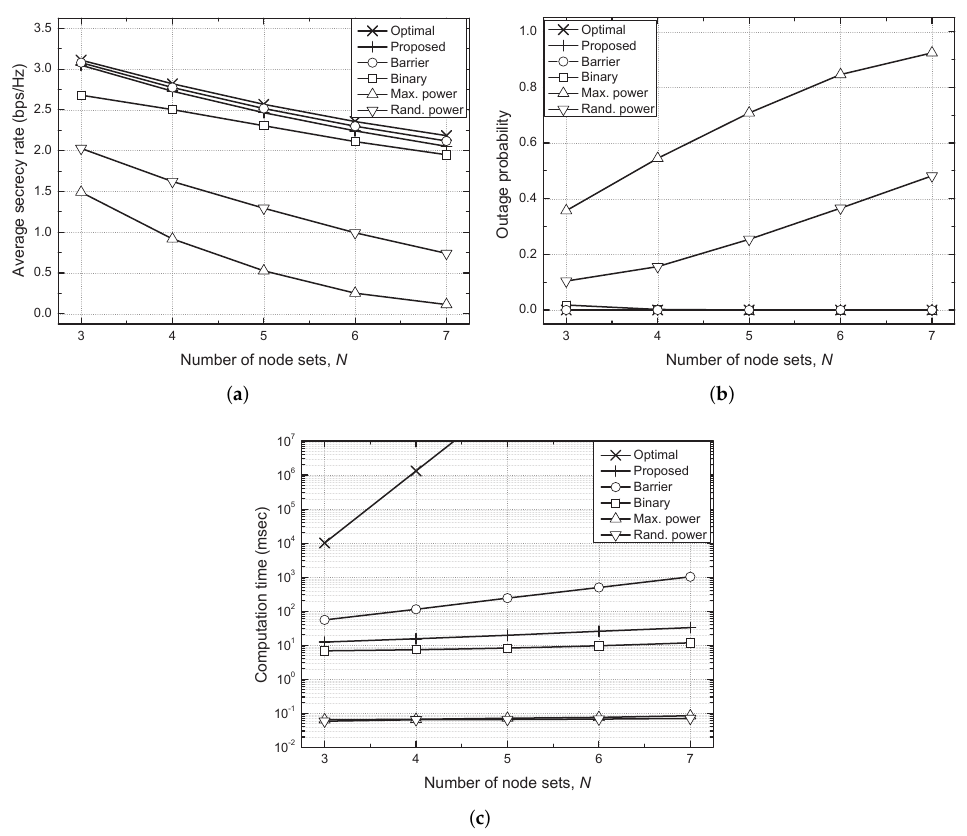
Figure 4. Performance comparison against number of node sets ( N ). ( a ) Average secrecy rate vs. N . ( b ) Outage probability vs. N . ( c ) Computation time vs. N